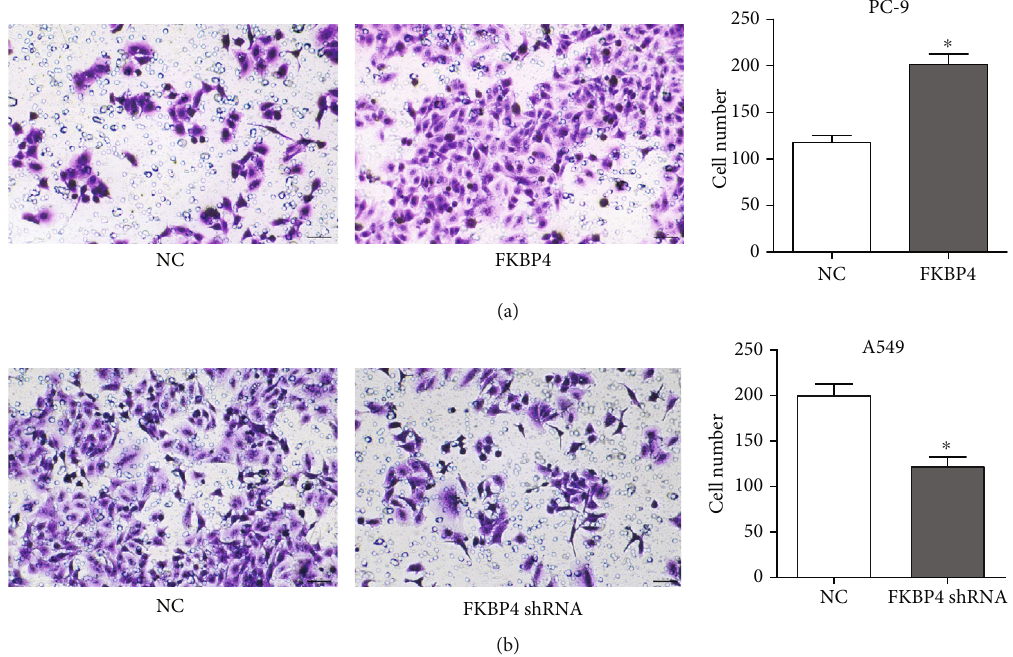
Figure 8: FKBP4 promotes NSCLC cell invasion: cell invasion after overexpression of FKBP4 (a) in PC-9 cells and silence of FKBP4 (b) in A549 cells; N = 3 , ∗ P < 0 : 05